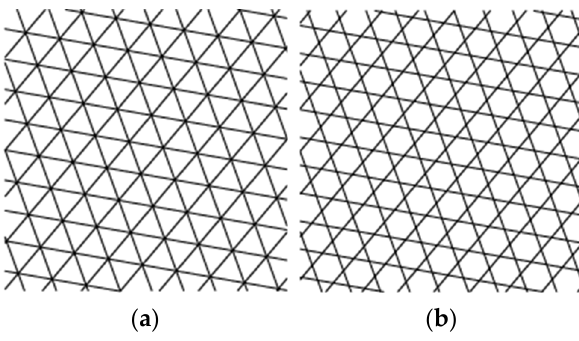
Figure 1. The infill patterns studied: ( a ) hexagonal, ( b ) star.